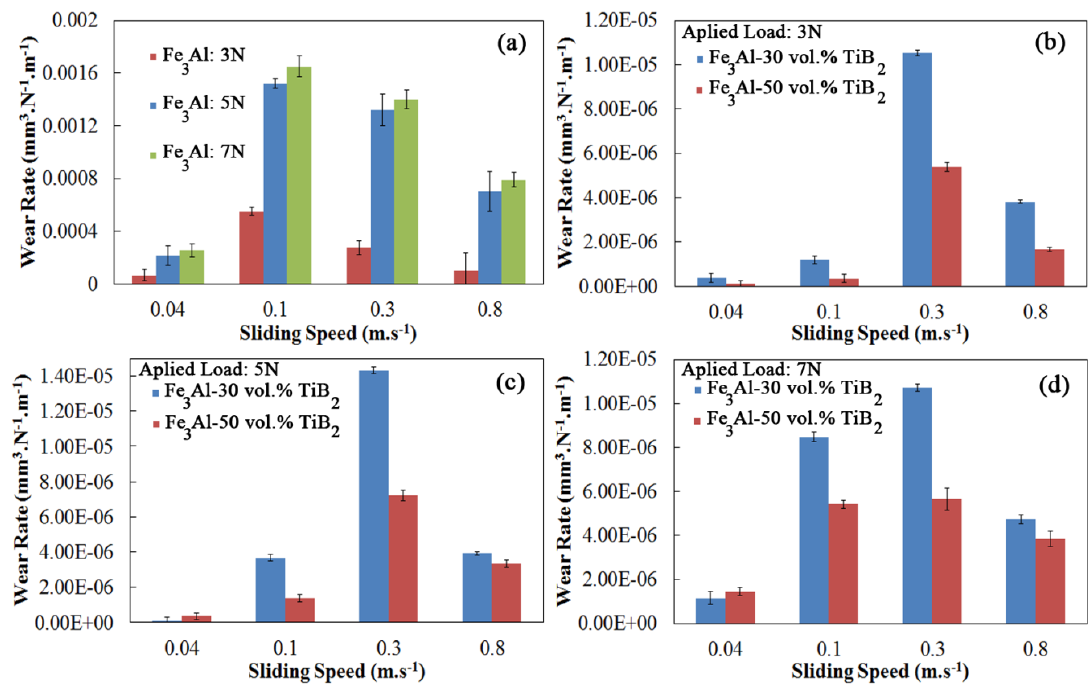
Figure 9. Wear rates as a function of sliding speed and applied load. ( a ) Fe 3 Al coatings and ( b – d ) composite